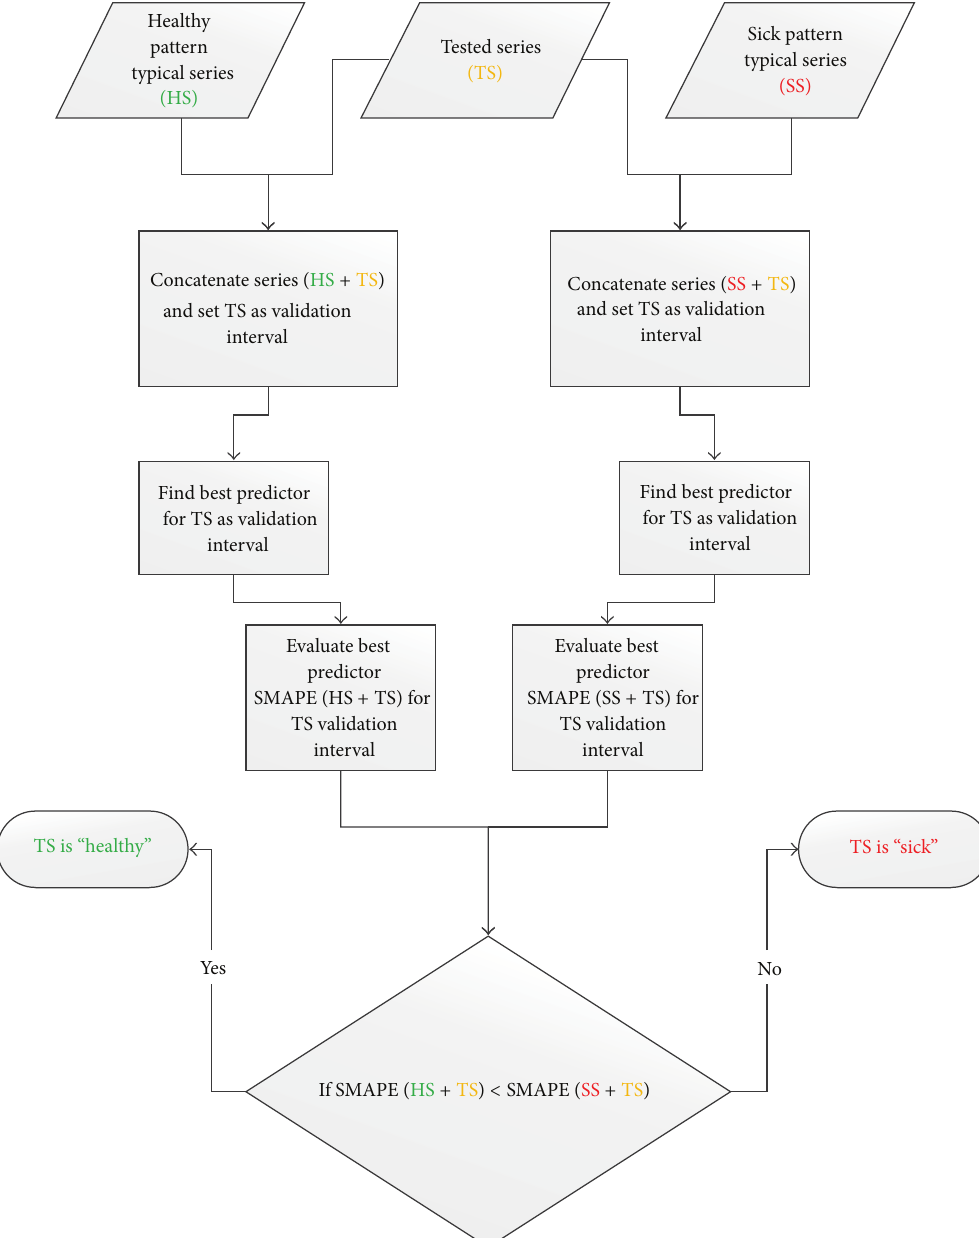
Figure 14: Recognition by linguistic fuzzy logic predictors for typical learning